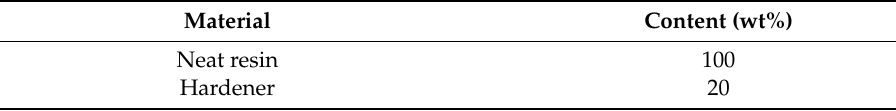
Table 1. Pure resin system components.